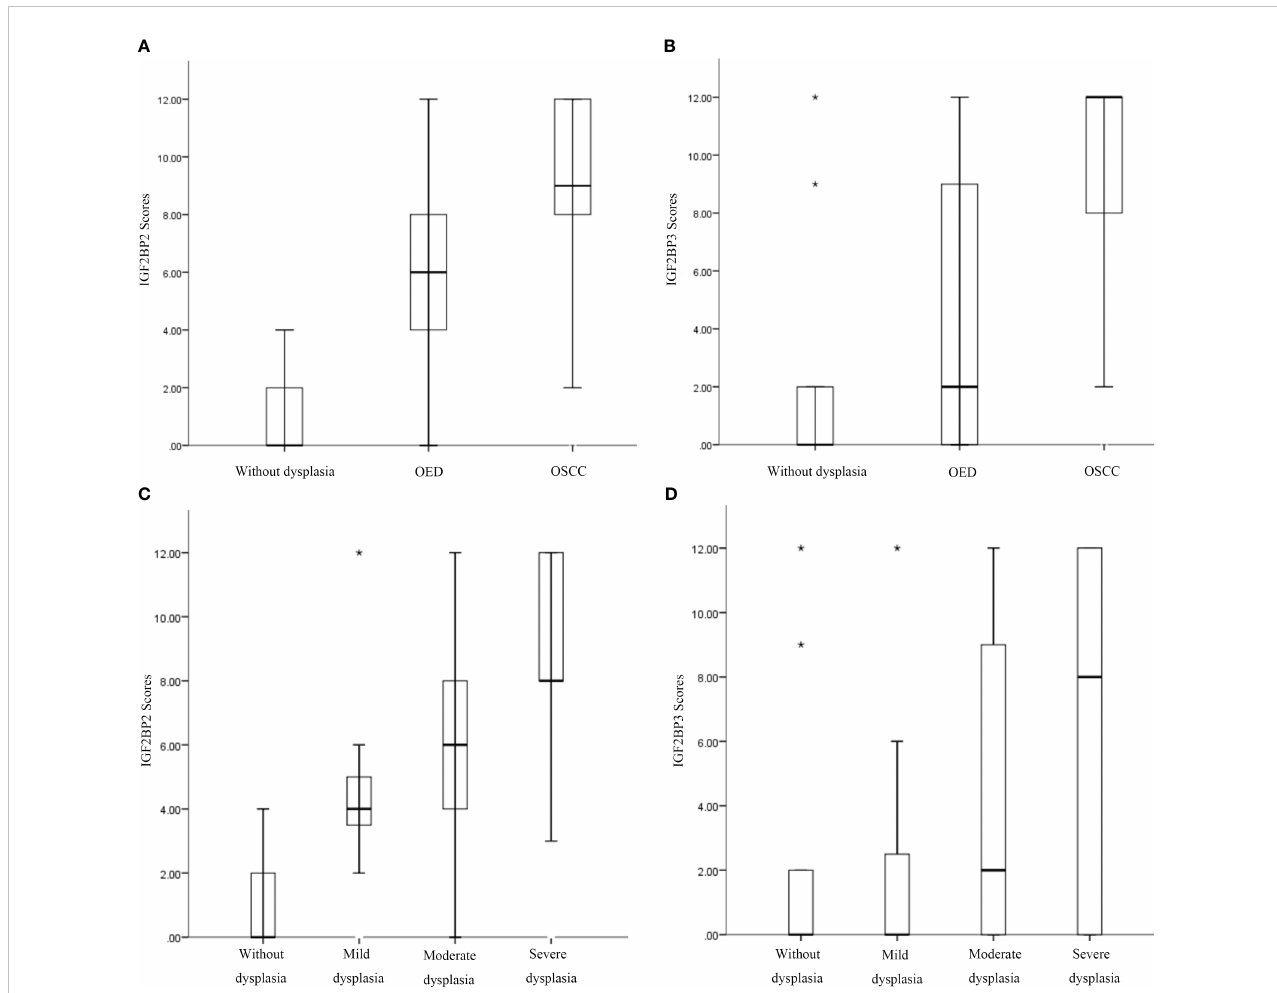
FIGURE 3 Increased expression of IGF2BP2 and IGF2BP3 was associated with the occurrence of oral squamous cell carcinoma (OSCC), oral epithelial dysplasia (OED), and progression of OED. (A, B) Immunohistochemical semiquantitative results of IGF2BP2 and IGF2BP3 expression in oral epithelial hyperplasia, OED, and OSCC. (C, D) Immunohistochemical semiquantitative results of IGF2BP2 and IGF2BP3 in epithelial hyperplasia, mild/moderate/severe epithelial dysplasia. *:extreme